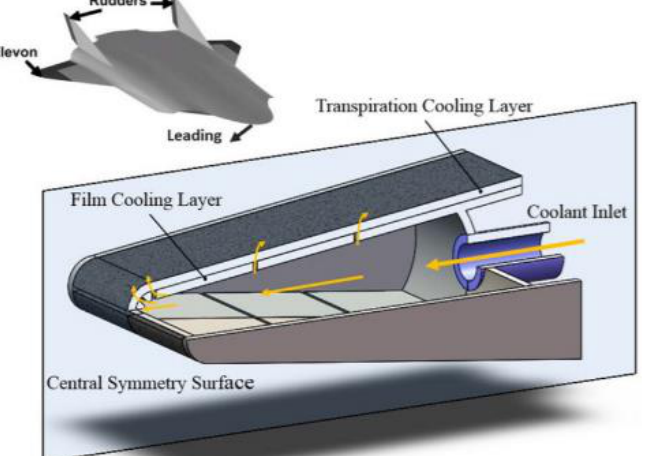
Figure 2. Transpiration cooling of the leading edge for a hypersonic vehicle. Reprinted/adapted with permission from Ref. [44] . 2020, Elsevier Ltd.